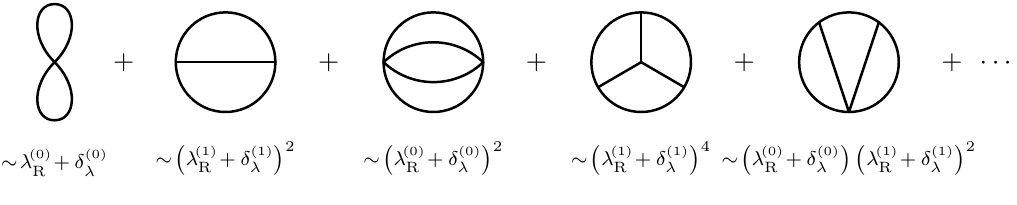
Figure 2 . The first few terms contributing to Γ 2 , including their precise coupling constant depen-